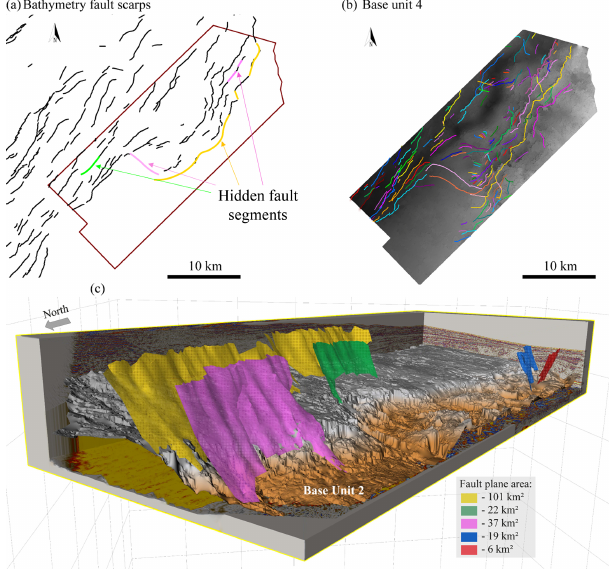
Figure 8. (a) Seabed faults in the Yam Hadera seismic survey with hidden fault segments marked in the same colors as the fault to which it is connected in panel (b) . (b) All faults are displacing base unit 4. Each fault is represented by one color. (c) Three-dimensional illustration of five faults with their measured fault plane area. Note that the yellow and the pink faults are not detected at the seabed in some parts (hidden fault segments) despite their large plane area (101km 2 and 37km 2 , respectively), and their colors are the same as in panel (b) . Figure 9. Classification of faults according to structure and loca-